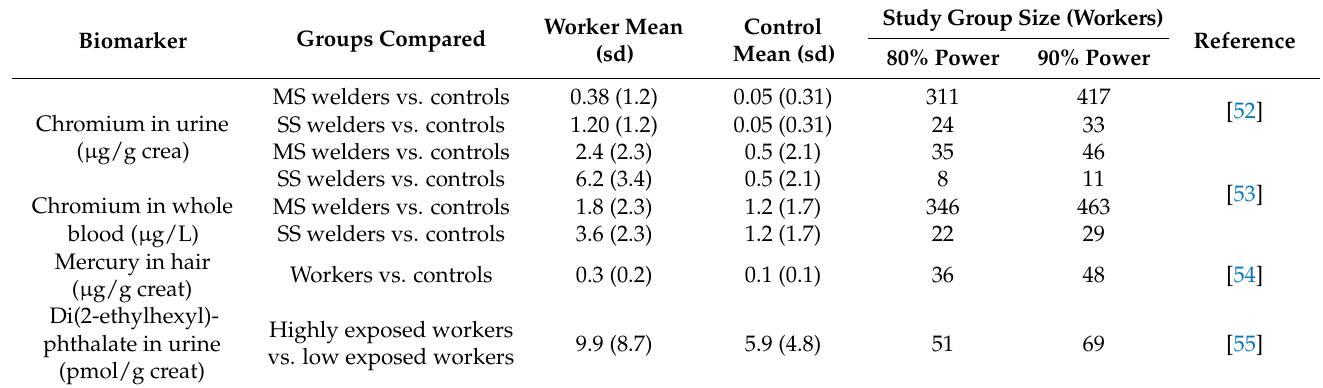
Table 6. Power calculation with an alpha of 0.05 for comparison of workers with controls for chemical exposures relevant to e-waste. The enrolment ratio is 2:1 (exposed:controls).